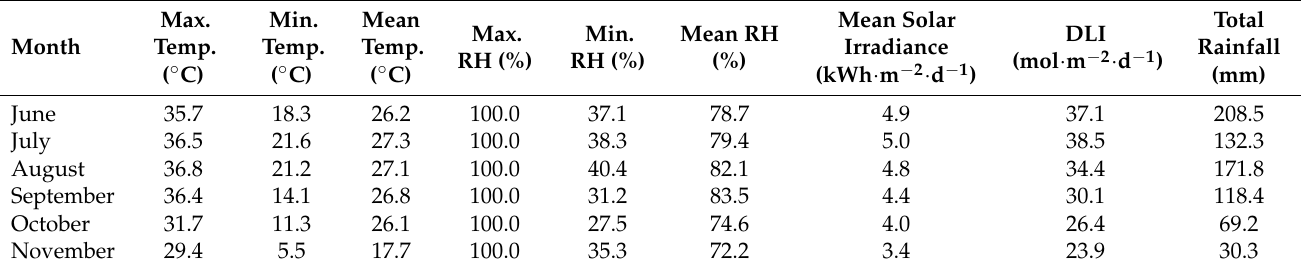
Table 2. Average monthly maximum (Max.), minimum (Min.), and mean air temperature (Temp.); relative humidity (RH); mean solar irradiance; daily light integral (DLI); and total rainfall measured throughout Experiment 2 conducted in 2020 at the Field and Fork Farm in Gainesville, FL,